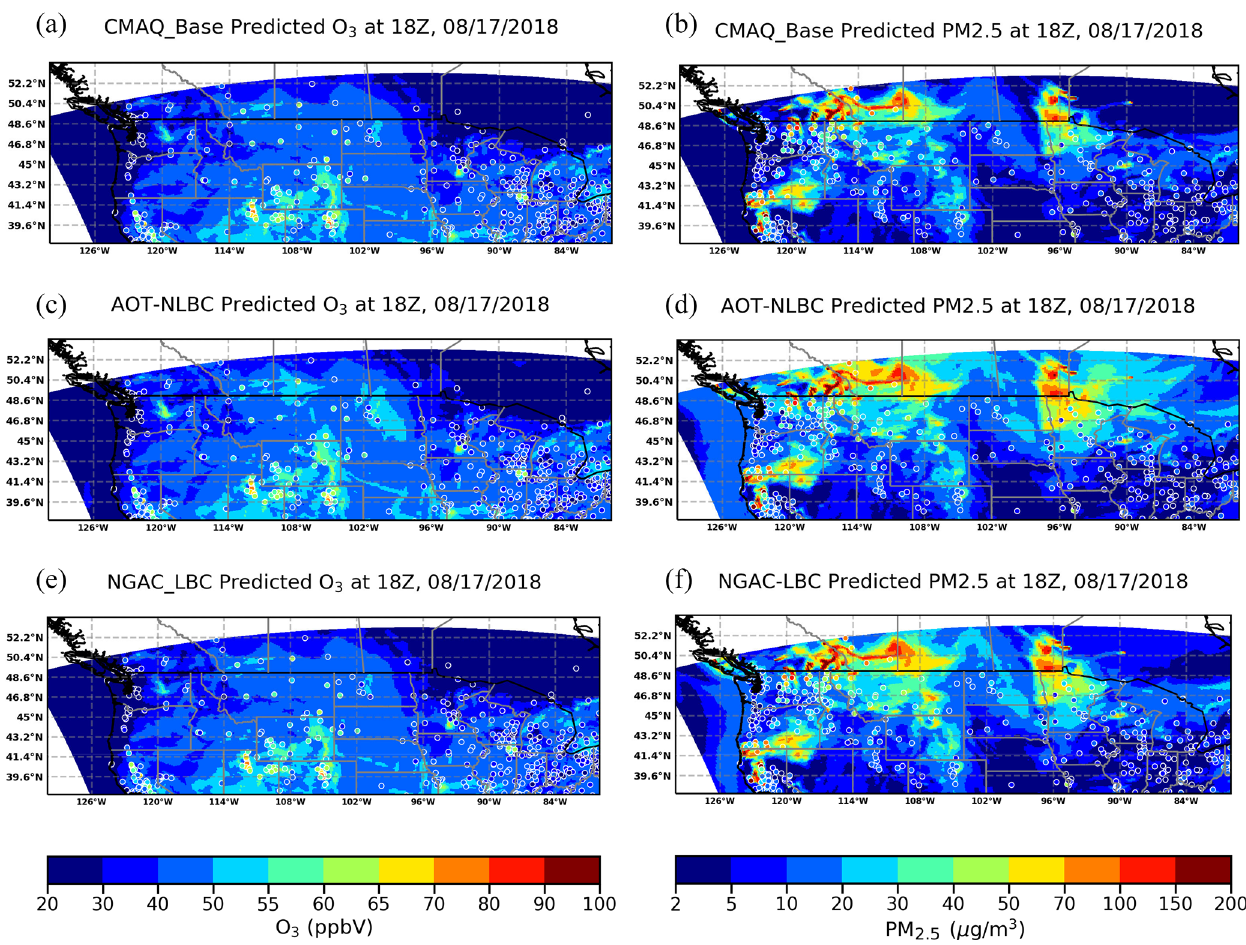
Figure 13. Model-predicted surface ozone (a, c, e) and PM 2 . 5 (b, d, f) with CMAQ_Base (a, b) , AOT-NLBC (c, d) , and NGAC-LBC (e, f) for 17 August 2018 (the colored circles show the AIRNow observations). Please note that the dates in this figure are given in the format of month day year (mm/dd/yyyy). This figure is plotted using cartopy https://scitools.org.uk/cartopy/docs/latest/ (last access: February 2021), which uses the national and state border information from http://www.naturalearthdata.com/ (last access: February 2021). Please note that the above figure contains incomplete US state